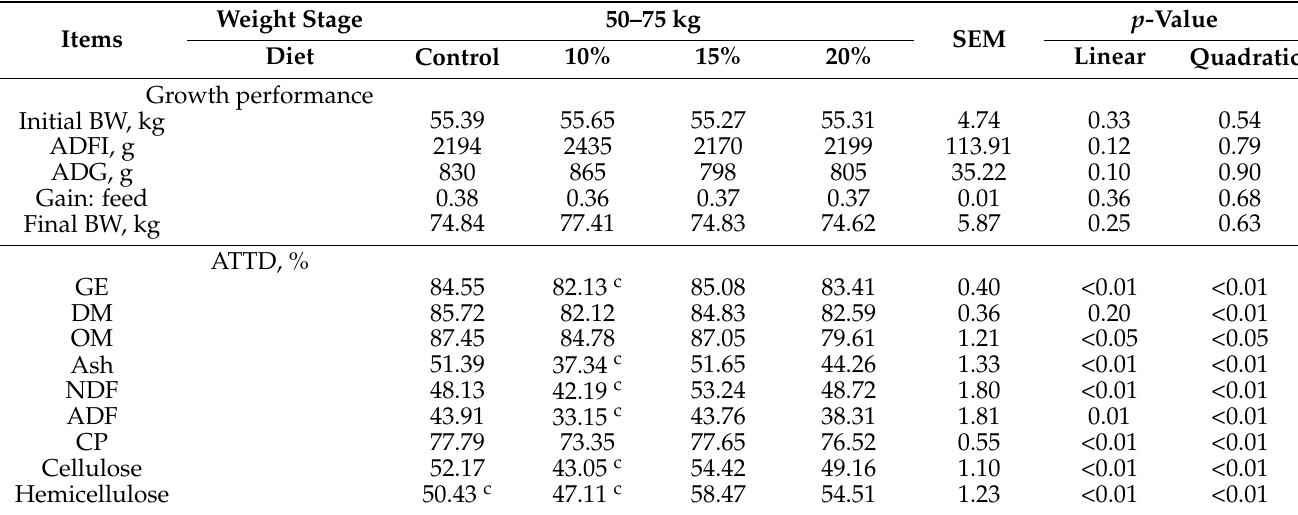
Table 4. Effects of inclusion level of defatted rice bran on growth performance and apparent total tract digestibility in weight stage 2 1